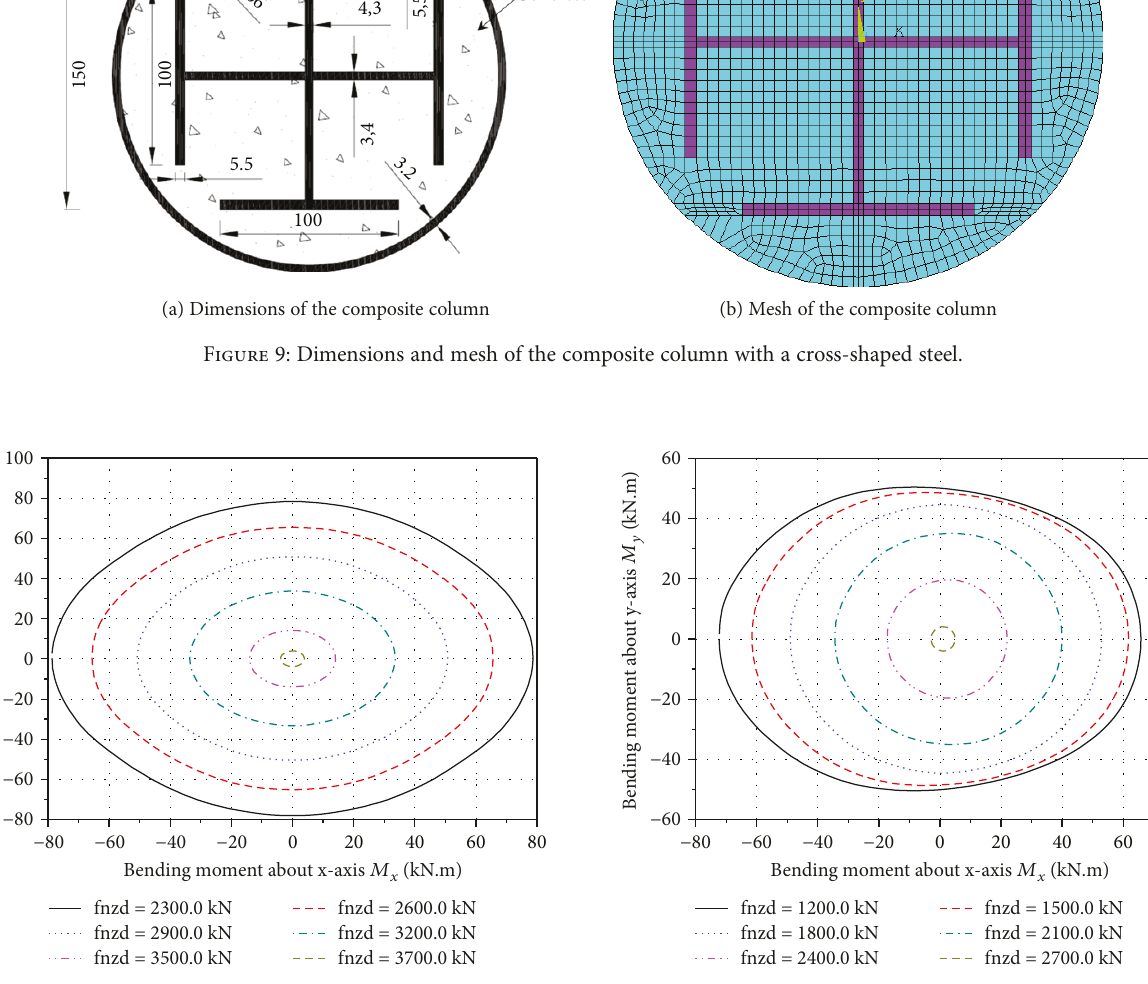
− M Figure 10: M x y interaction curves of the composite column with a cross-shaped steel under di ff erent axial load levels.